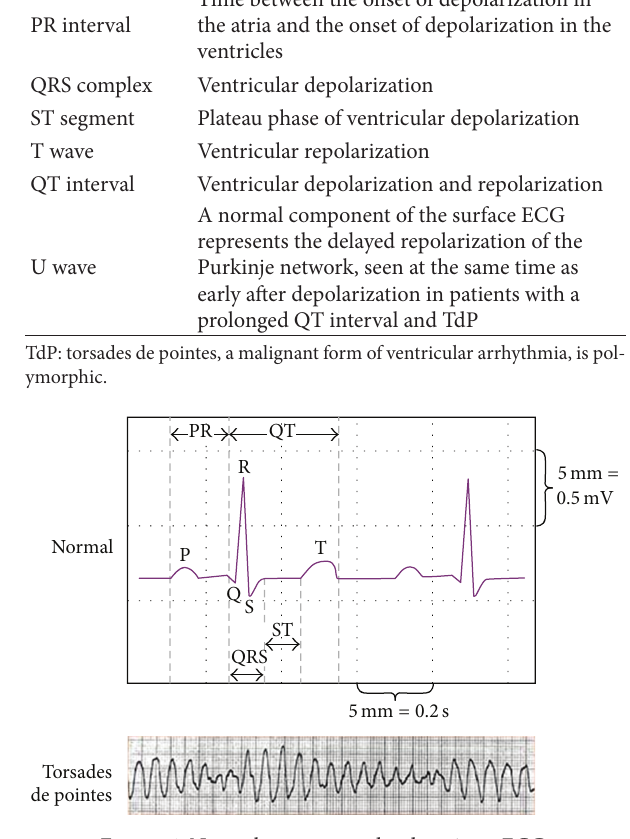
Figure 1: Normal versus torsades de pointes